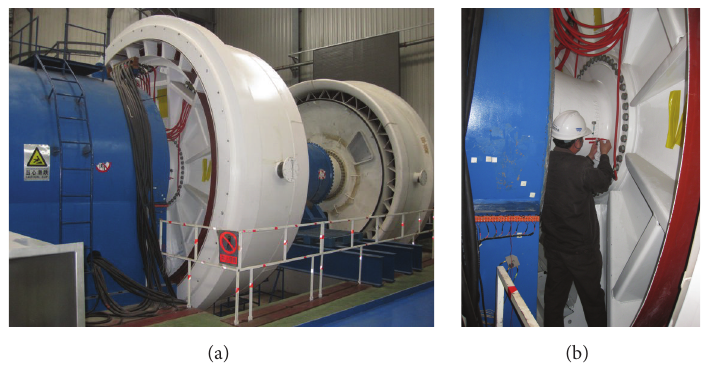
Figure 6: Test platform of direct drive wind turbine. (a) Platform and (b) transducer installation.